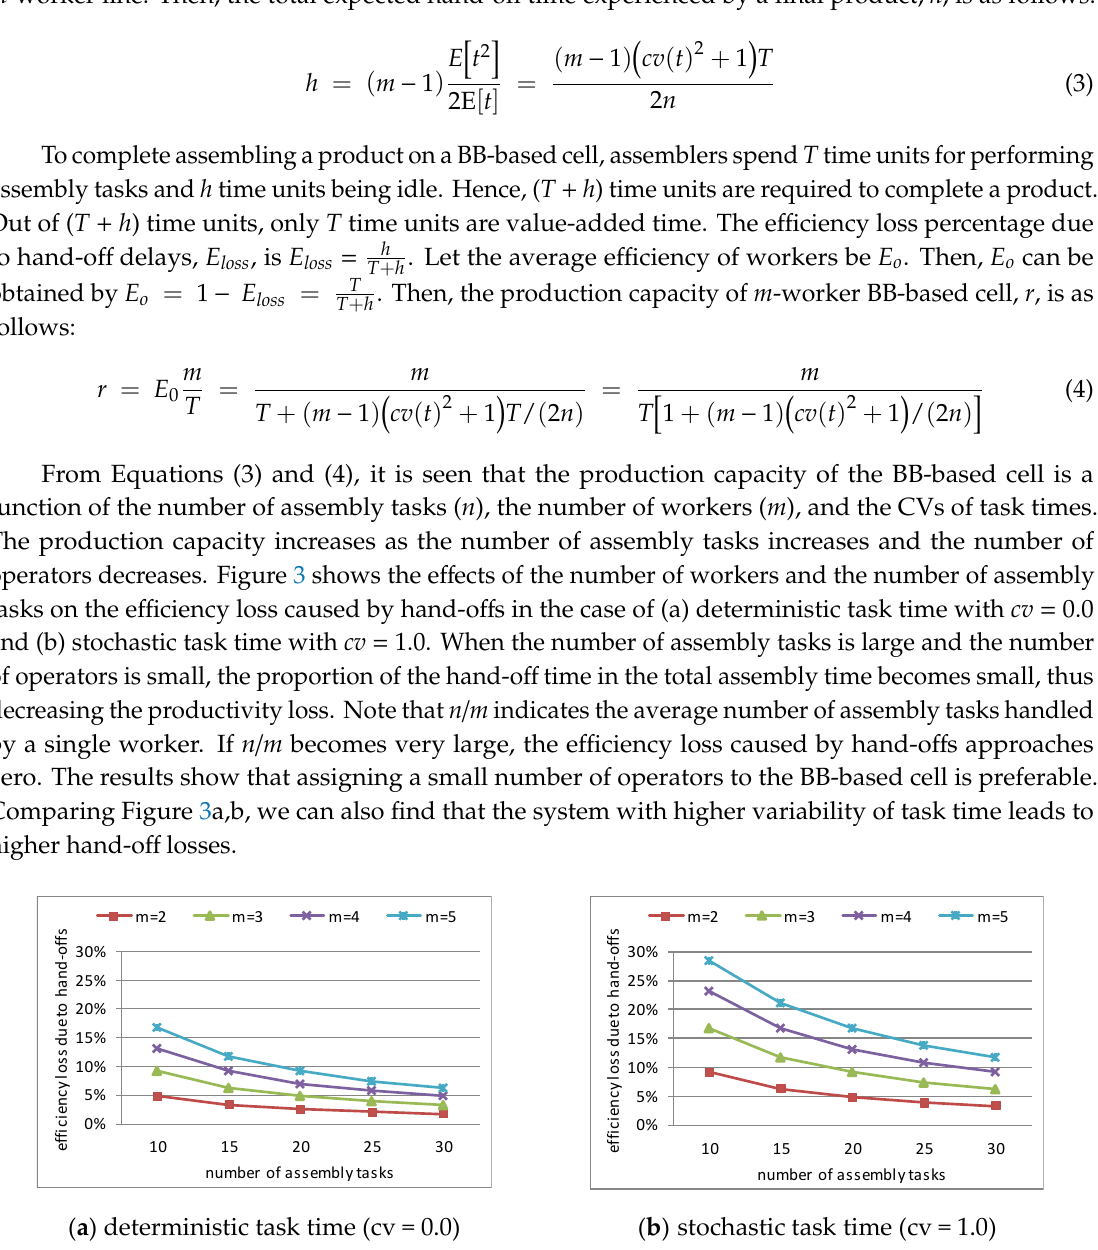
Figure 3. E ffi ciency loss in BB assembly cell with hand-o ff times under ( a ) deterministic task time Figure 3. Efficiency loss in BB assembly cell with hand-off times under ( a ) deterministic task time (cv (cv = 0.0) and ( b ) stochastic task time (cv = 1.0). It is seen that the hand-o ff losses are increased by = 0.0) and ( b ) stochastic task time (cv = 1.0). It is seen that the hand-off losses are increased by (1)